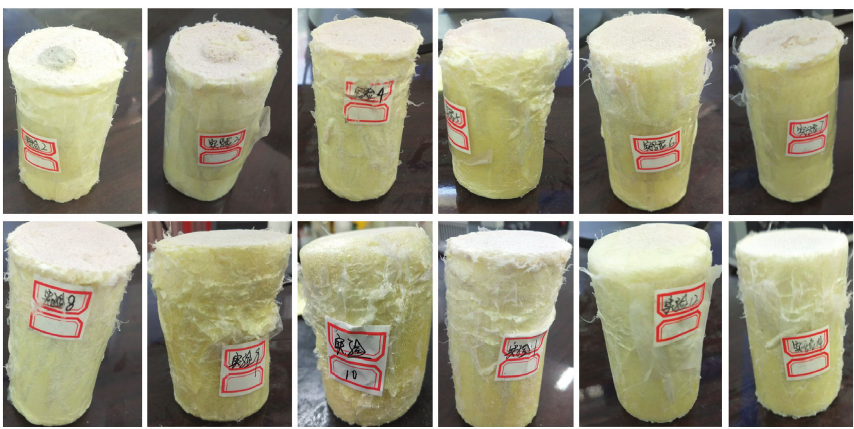
Figure 7: Plastic failure and deformation of